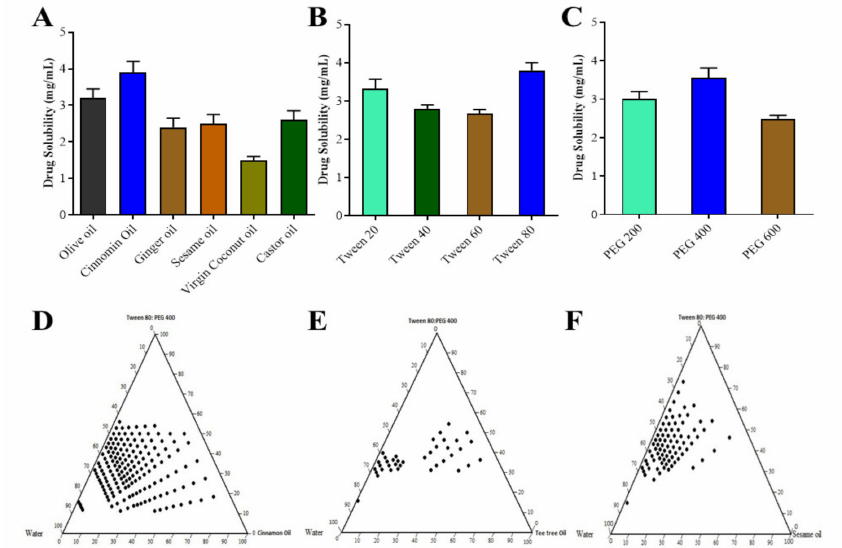
Figure 1. Solubility studies of pitavastatin in oils ( A ), surfactants ( B ), and co-surfactants ( C ); pseudo ternary phase diagram in cinnamon oil ( D ), tea tree oil ( E ) and sesame oil ( F